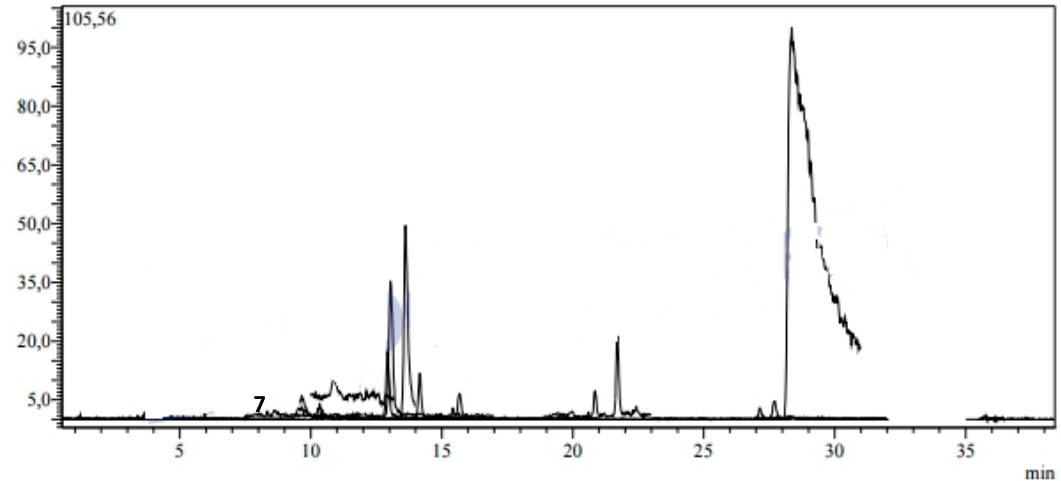
Figure 4. LC-MS / MS chromatogram of BuOH extract of H. laevigata var. hipponensis . Figure 4. LC-MS/MS chromatogram of BuOH extract of H. laevigata var. hipponensis .